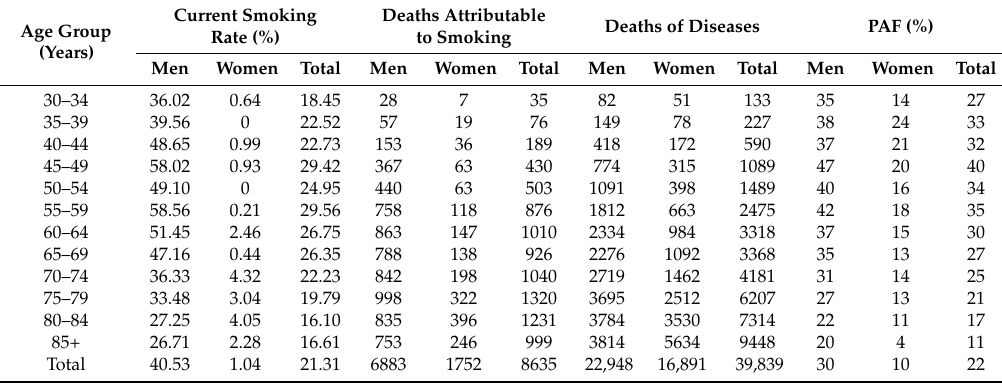
Table 3. Number of deaths attributable to smoking and PAF of diseases by age and sex. Age Group